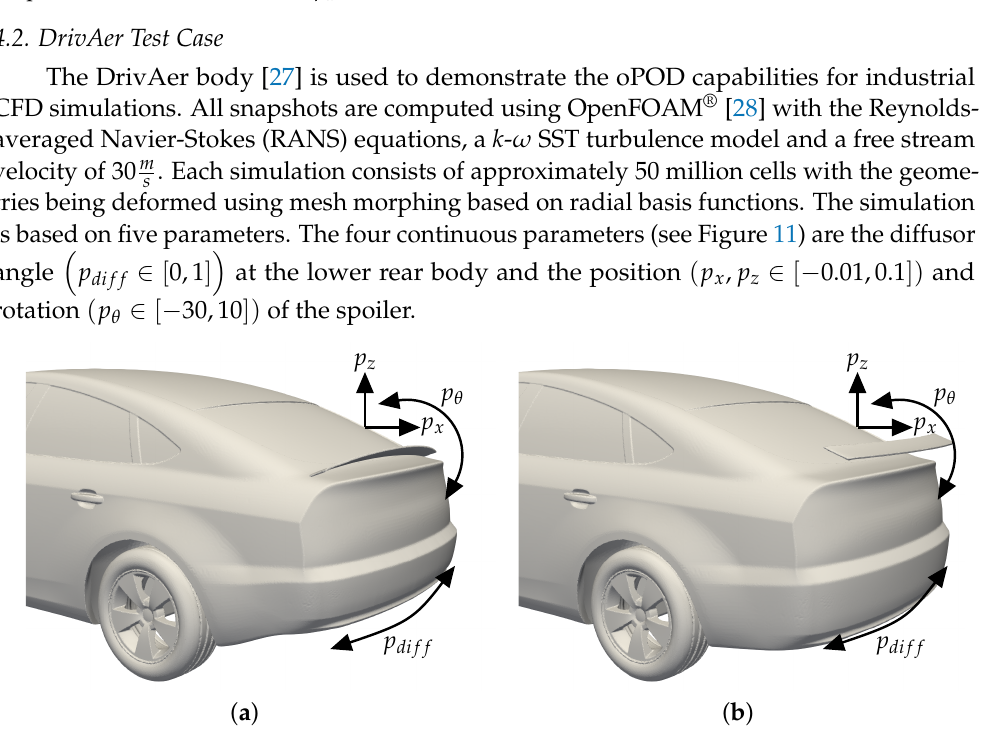
Figure 11. Parameter variation for the DrivAer test case. ( a ) Minimal DrivAer body parameter values. ( b ) Maximal DrivAer body parameter